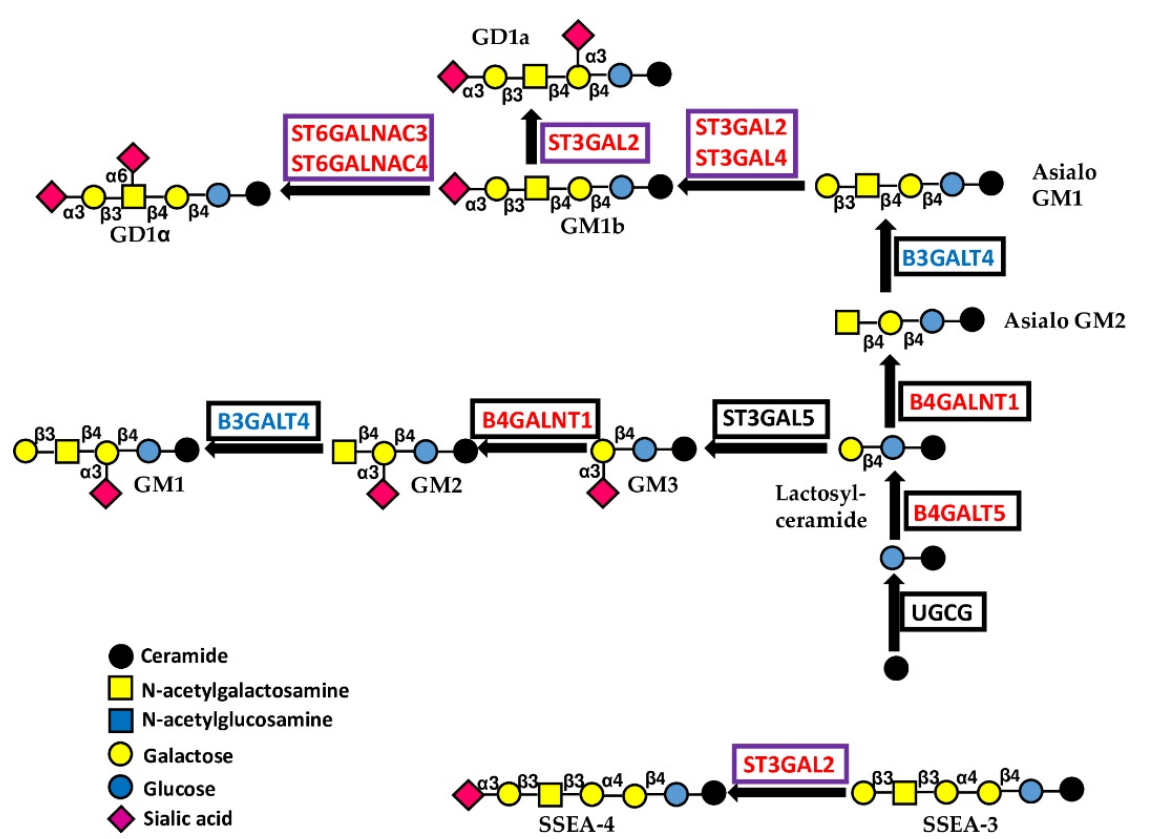
Figure 5. Biosynthesis and structure of gangliosides. The sugar linked to ceramide is glucose. Enzymes catalyzing core glycosylation are boxed in black, while those catalyzing chain capping are boxed in violet.